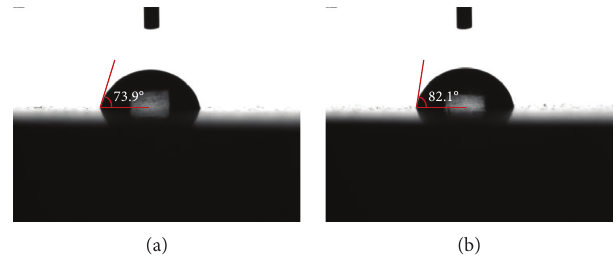
Figure 5: Contact angles of two coal samples. (a) Coal 1. (b) Coal 2.